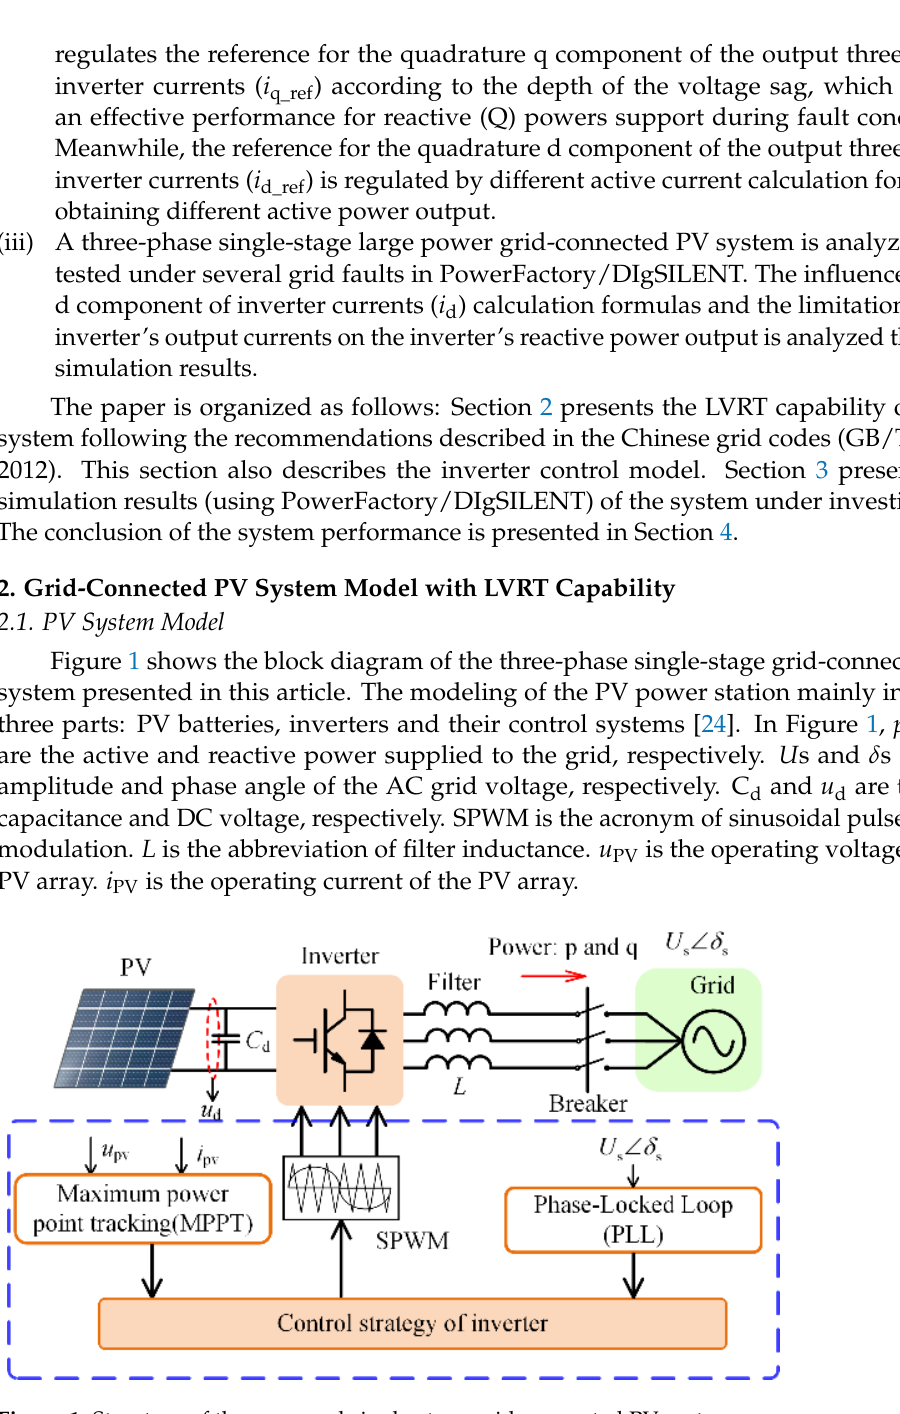
MPP, the operation point of PV array will shift from the maximum power point to the left side of the maximum power point. When the MPPT algorithm is deactivated, the active